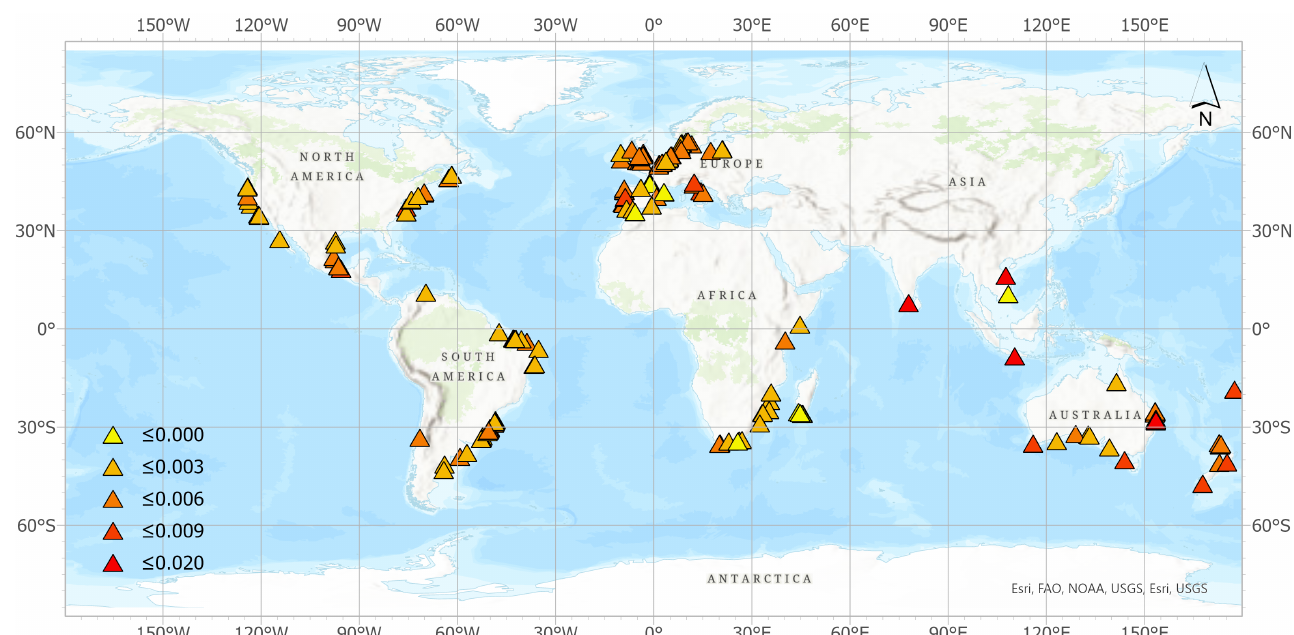
Figure 4. Dune dynamics based on Mann–Kendall analysis performed on the trend component of the NDVI series.